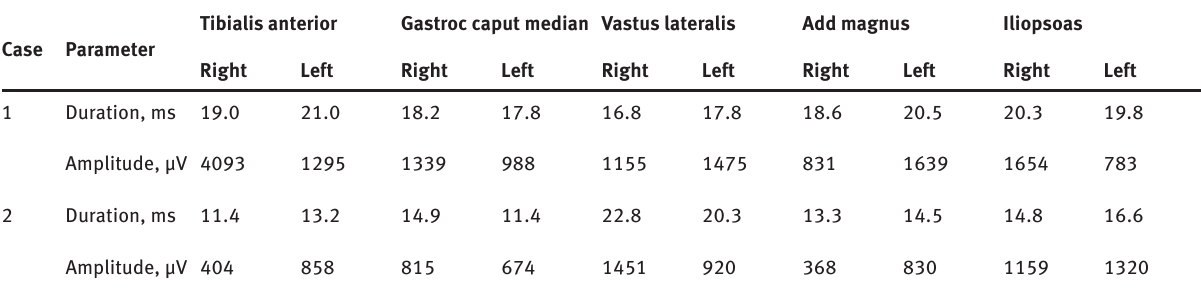
Table 2: Needle electromyography findings